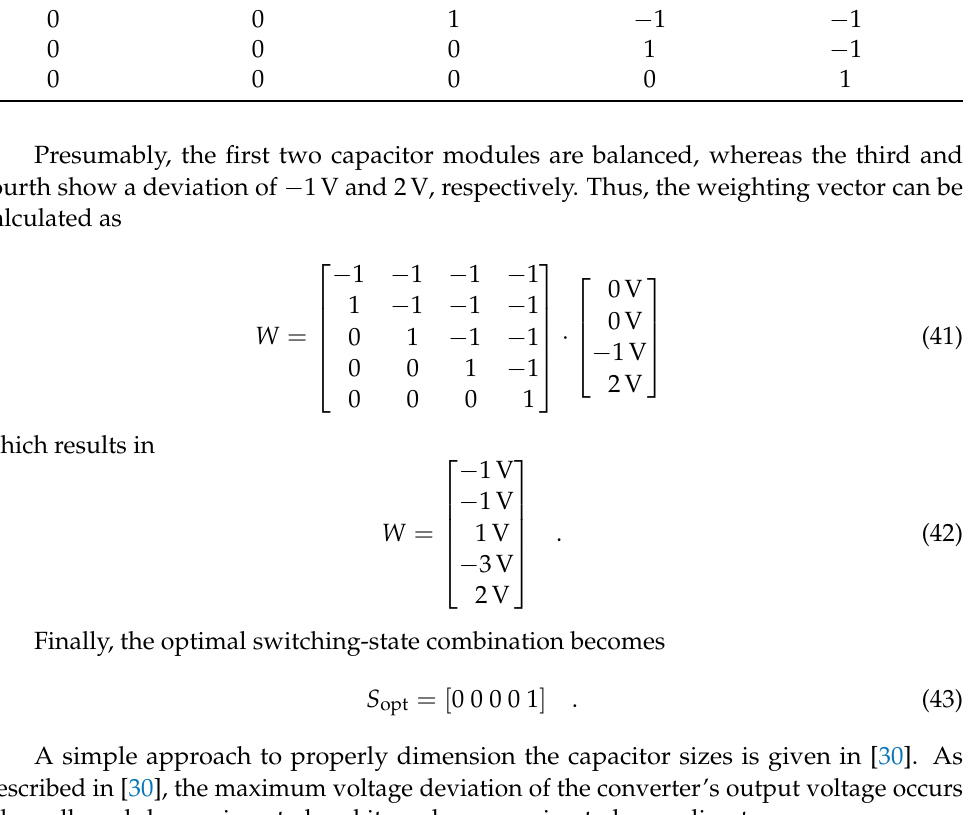
and n = 4, which gives m = 5 possi- 2 4